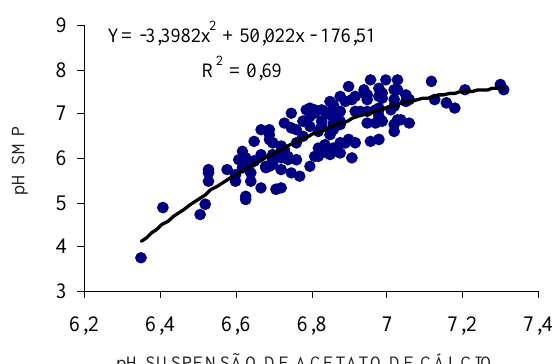
Figura 1. Relação entre o pH SMP e o pH da sus- pensão de acetato de cálcio.